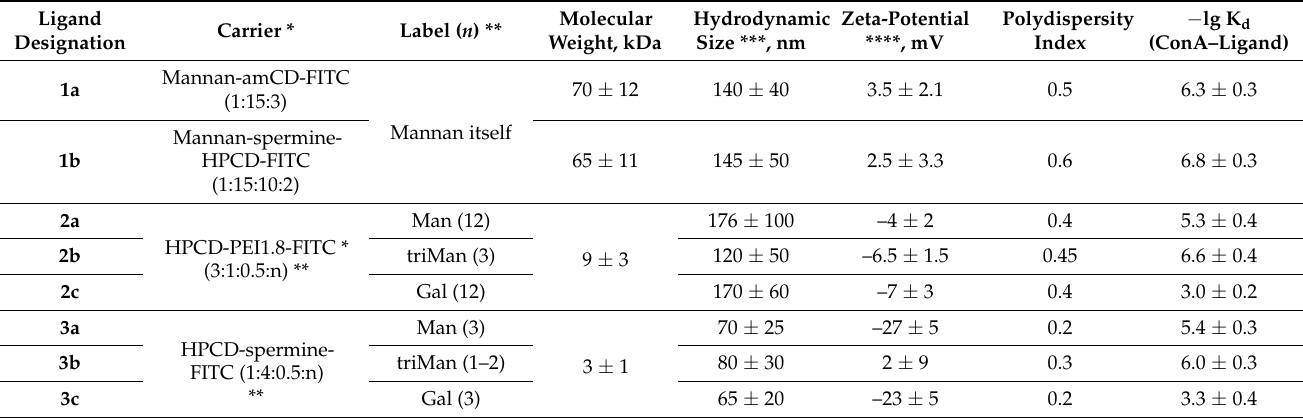
Table 1. Characteristics of drug delivery systems and their affinity to mannose receptor.